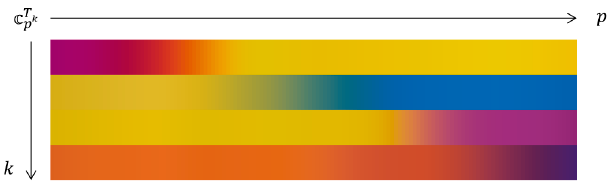
Figure 7. High-resolution calibrated target colors C T k p interpolated from C T k